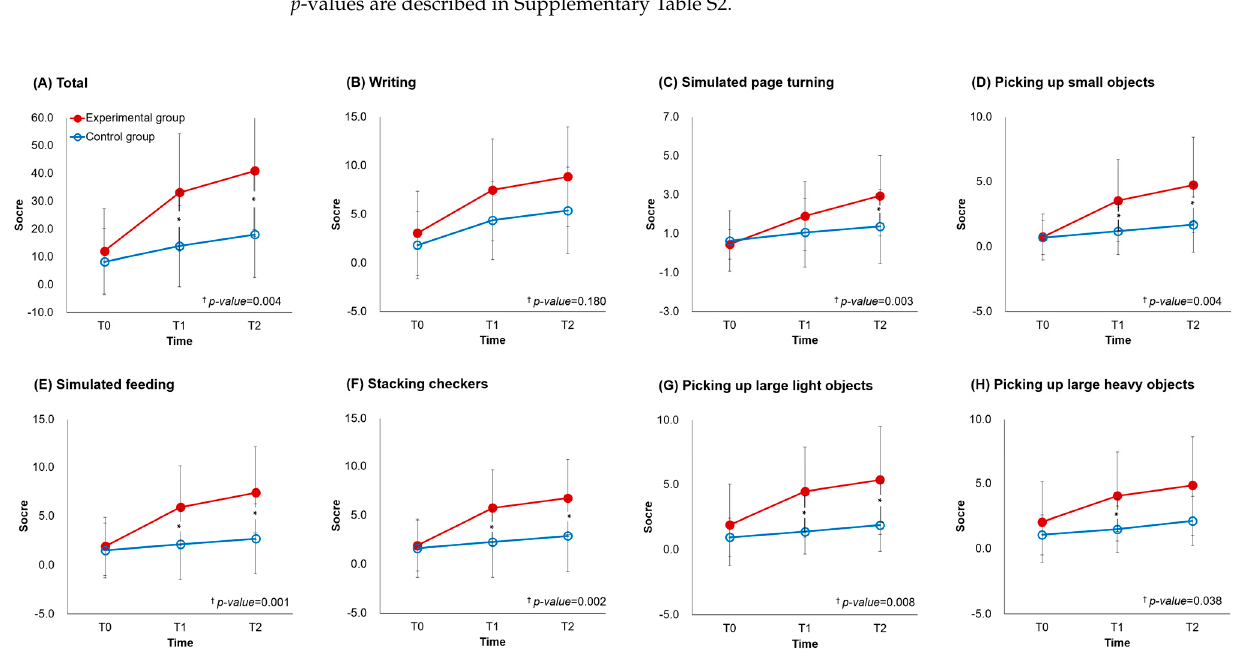
Figure 2. Fugl-Meyer assessment of upper extremity in experimental and control groups. T0, before the intervention; T1, immediately after the intervention; T2, four weeks after the intervention. * p < 0.05 between-group comparisons according to independent t -test or Mann-Whitney U test for continuous variables as appropriate after Bonferroni’s correction. † p -value according to repeated measure analysis of variance.